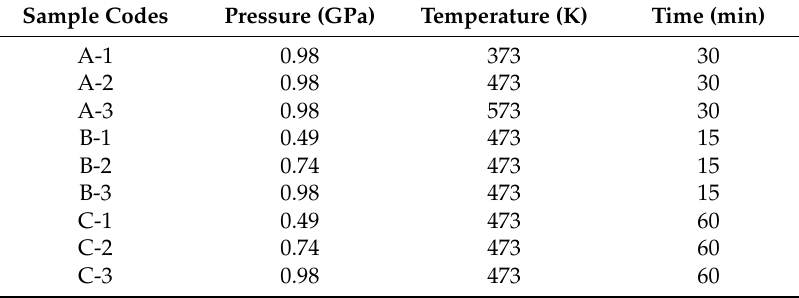
Table 1. Sample designations of vacuum hot pressing samples.